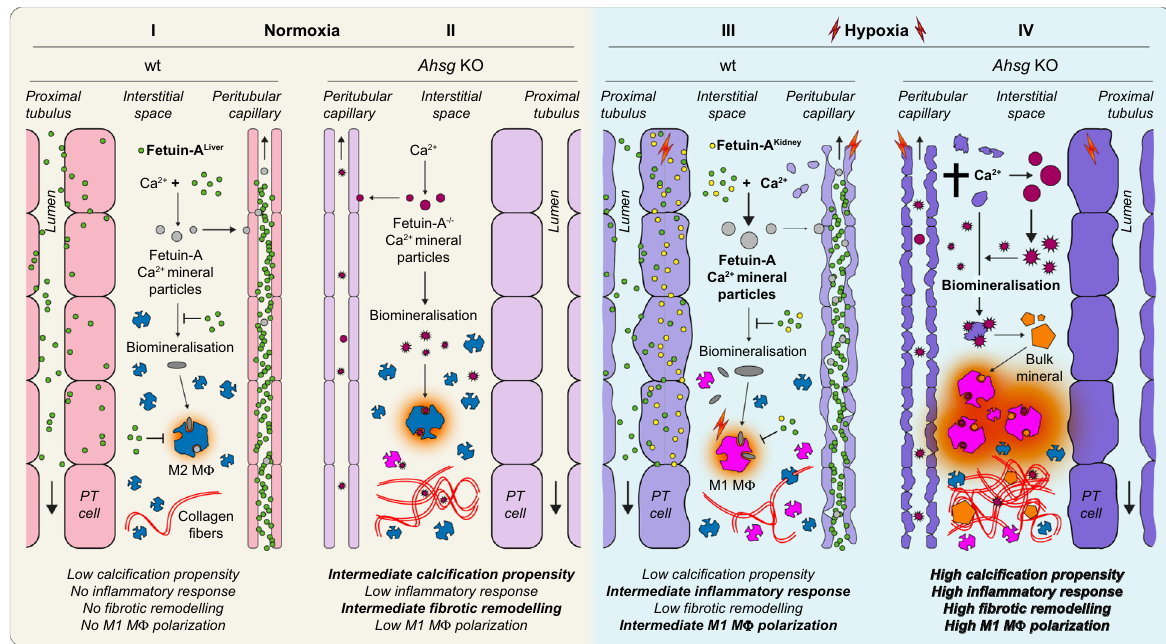
Fig. 9 Proposed model. Fetuin-A ( Ahsg ) is a HIF target gene that locally protects the kidney from hypoxia-induced renal damage and functional deterioration. It is implicated in the clearance of calcifying nanoparticles, mitigation of in fl ammation, attenuation of fi brotic tissue remodeling, and polarization of macrophages. (I) In normoxia, liver-derived fetuin-A (green) locally binds calcium in mineral particles (light gray), inhibits their maturation and accumulation (dark gray). Macrophages exhibit an M2 anti-in fl ammatory phenotype (M2 M Φ , blue). (II) The relatively low abundance of fetuin-A-free calcium biominerals (dark red) in normoxic conditions is not suf fi cient to elicit a noticeable in fl ammatory response. The majority of macrophages is M2 polarized, only a small fraction shows a M1 pro-in fl ammatory phenotype (M1 M Φ , magenta). (III) In hypoxia, increased tissue damage leads to calcium mineral overload and a polarization shift towards M1 M Φ . However, local induction of fetuin-A (yellow) augments the clearance of calcium biominerals and keeps the polarization of M1 M Φ in check, thus preventing in fl ammation and fi brotic remodeling. (IV) Fetuin-A de fi ciency in an hypoxic environment leads to an unbalanced accumulation of calcium biominerals and their unchecked maturation (orange), which overwhelms the intrinsic clearing capacity of the tissue. This further promotes the polarization of pro-in fl ammatory M1 M Φ , and culminates in in fl ammation (red) and fi brotic tissue